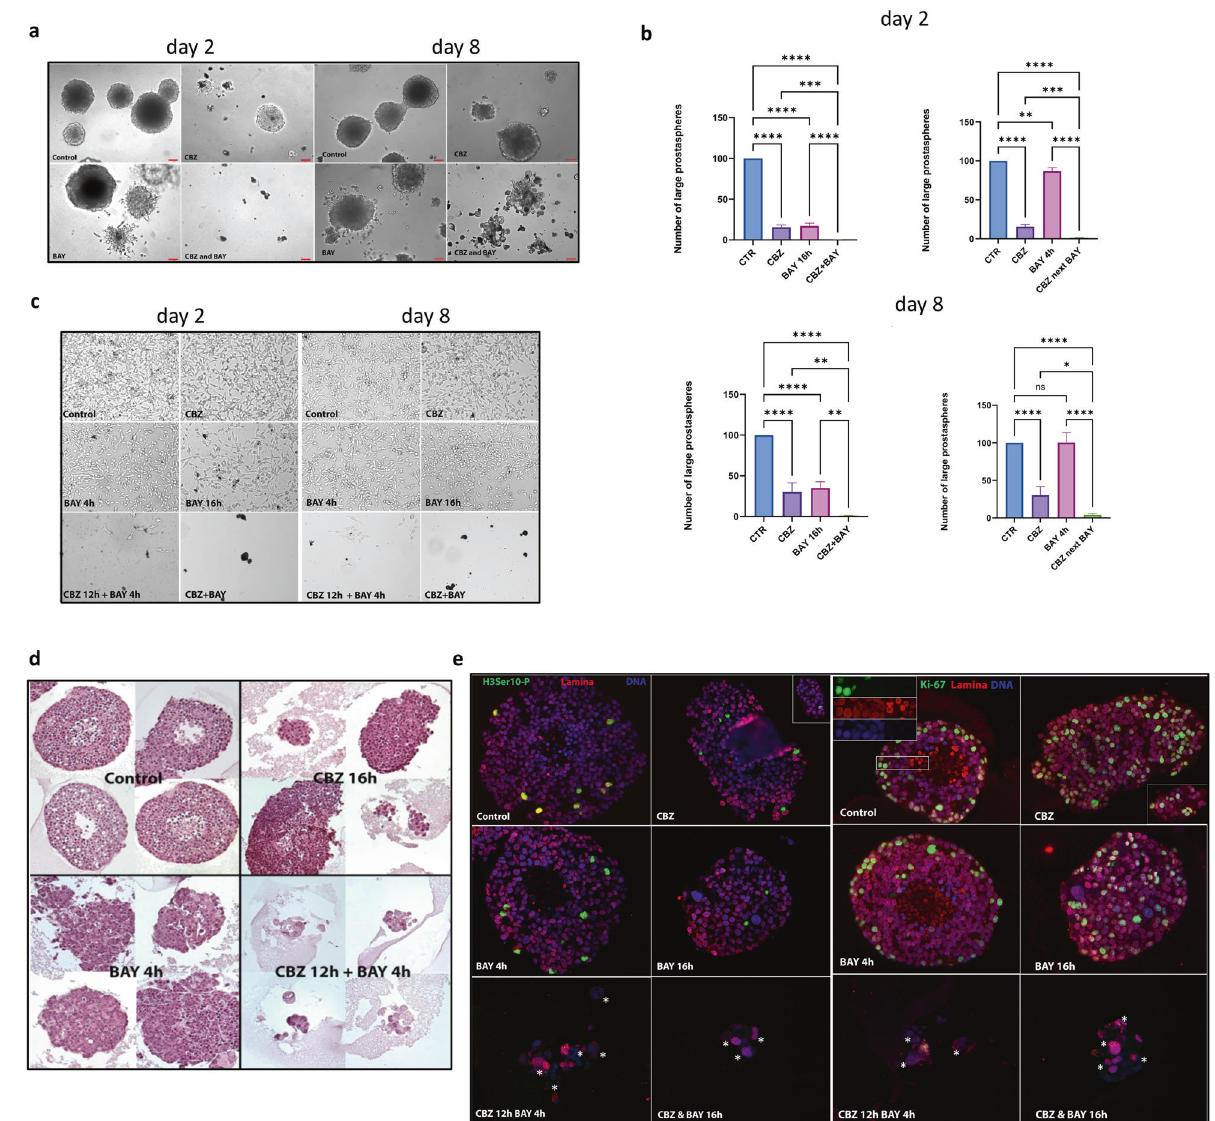
Fig. 2 Mps1i BAY potentiates ef fi cacy of CBZ treatment in 3D prostasphere settings. C4-2B cells were set in Matrigel and treated at day 2 or day 8 in triplicates with CBZ (1.5 nM) 16 h, BAY (32 nM) 4 h and 16 h, CBZ + BAY 16 h, CBZ 12 h next BAY 4 h. Prostaspheres were treated at day 2 ( a , left) and day 8 ( a , right), and documented ( a ) or counted ( b ) at day 21. In b, columns: mean; error bars: standard deviation. * p < 0.1; ** p < 0.01: *** p < 0.001; **** p < 0.0001. c : Prostaspheres were treated at day 8; at day 21, equal volume of trypsinized cells was re-plated in six- well plates and documented 48 h later. d , e Prostaspheres were treated at day 8 as indicated and fi xed 14 days later. Sections stained with: d H&E or e with H3Ser10-P (green, left panel, mitotic marker) or Ki-67 (green, right panel, proliferation marker), lamina (red), and DNA (blue); asterisk for MN